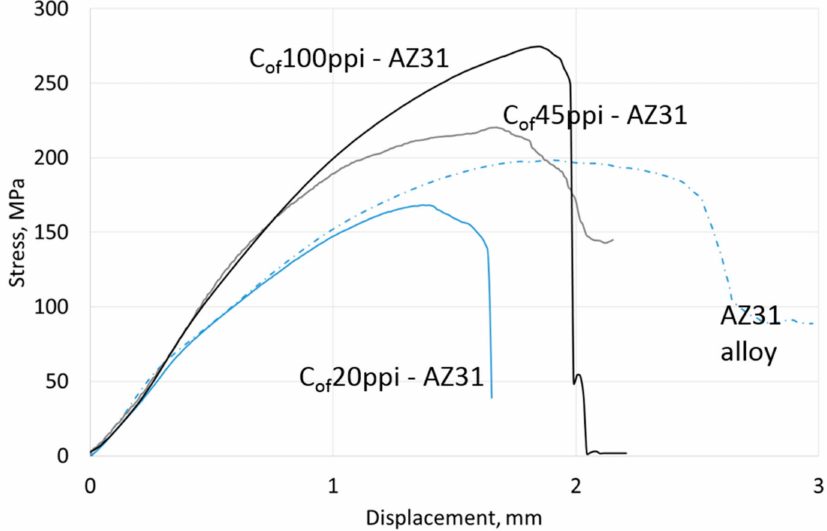
Figure 7. Representative curves obtained in compressive strength tests of AZ31 matrix composites with C of 20ppi, C of 45ppi and C of 100ppi.